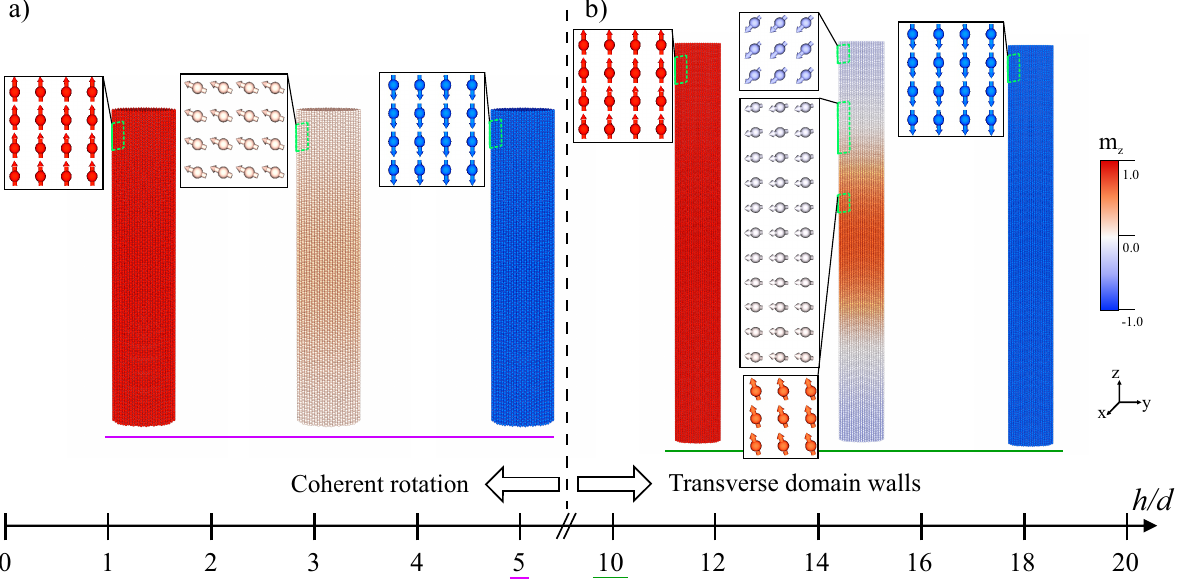
Figure 4. Snapshots of the spin configurations of a single cylindrical nanostructure with the aspect ratio h / d = 5 ( a ) and h / d = 10 ( b ) for a magnetic field applied in a parallel direction to the object axis, showing two different spin reversal modes, characteristic of h / d < 10 and h / d ≥ 10. The color changes with the projection of the spin along the direction of the external field. The boundary cases correspond to pure red and pure blue colors for the spins aligned along the nanostructures axis, in up and down directions, while white colors mean spins aligned perpendicular to the axis of cylindrical